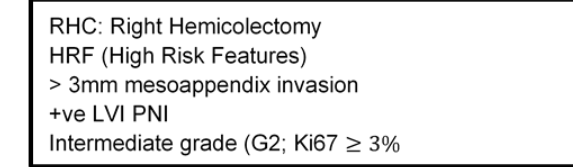
Figure 2. Surgical Treatment of Localized ANENs after Simple Appendectomy.